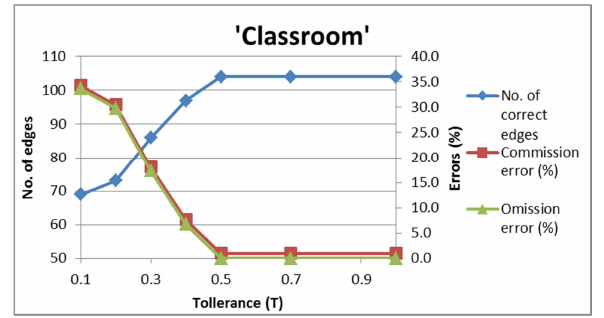
Figure 10. Accuracy evaluation of edge segmentation results for the ‘Classroom’ data set.